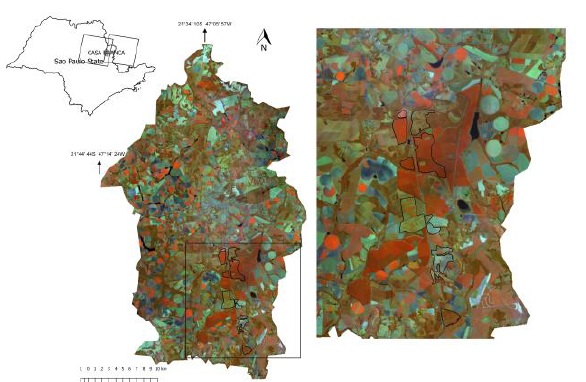
Figure 1. False color (bands 5, 6 and 4 in red, green and blue respectively) OLI Landsat imagery of the study